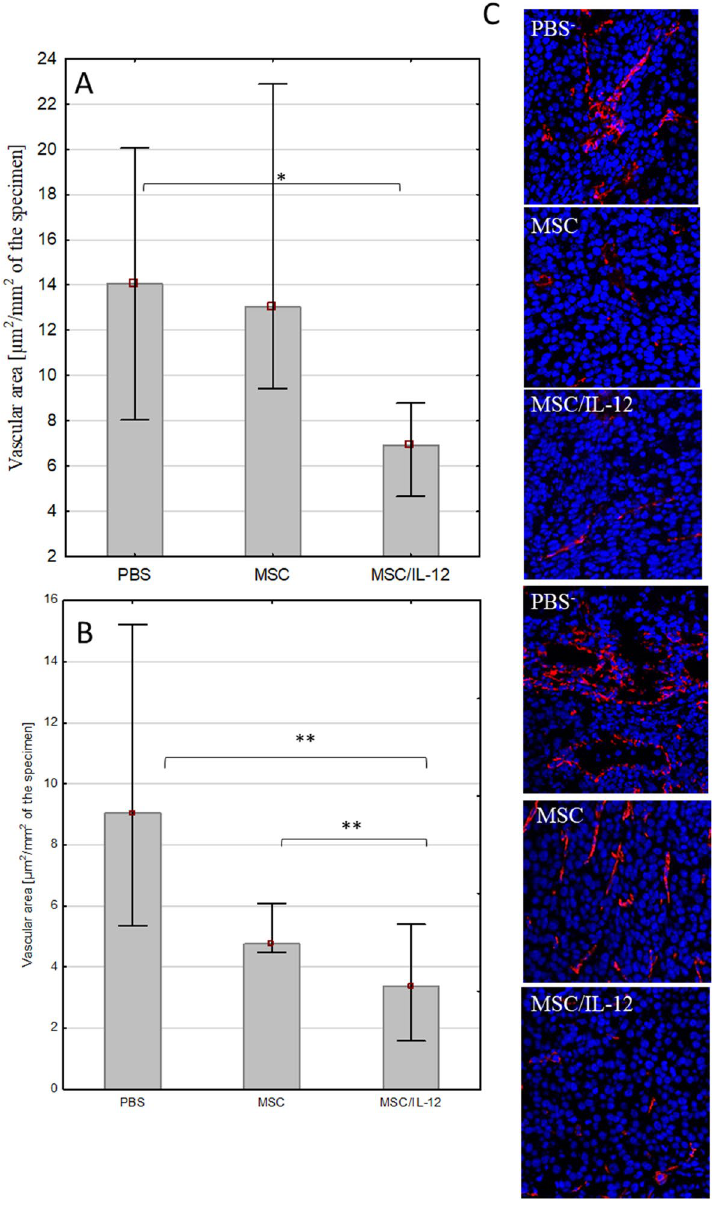
Figure 11. The effect of applied therapy on blood vessels in tumors excised 3 ( A ) and 8 ( B ) days after administration of MSC/IL-12 (n = 5). Area occupied by the vessels [μm 2 /mm 2 of the preparation]. The area of vessels in tumors collected from mice treated with MSC/IL-12 cells was twofold lower than in tumors from mice that received PBS - , both on the 3rd and 8th day of therapy. Representative images of tumor sections from mice treated with PBS, unmodified MSC or MSC/IL-12 (C). Endothelial cells—CD31 (AlexaFluor594, red), cell nuclei (DAPI, blue), lens magn. × 20, *p < 0.05, **p <